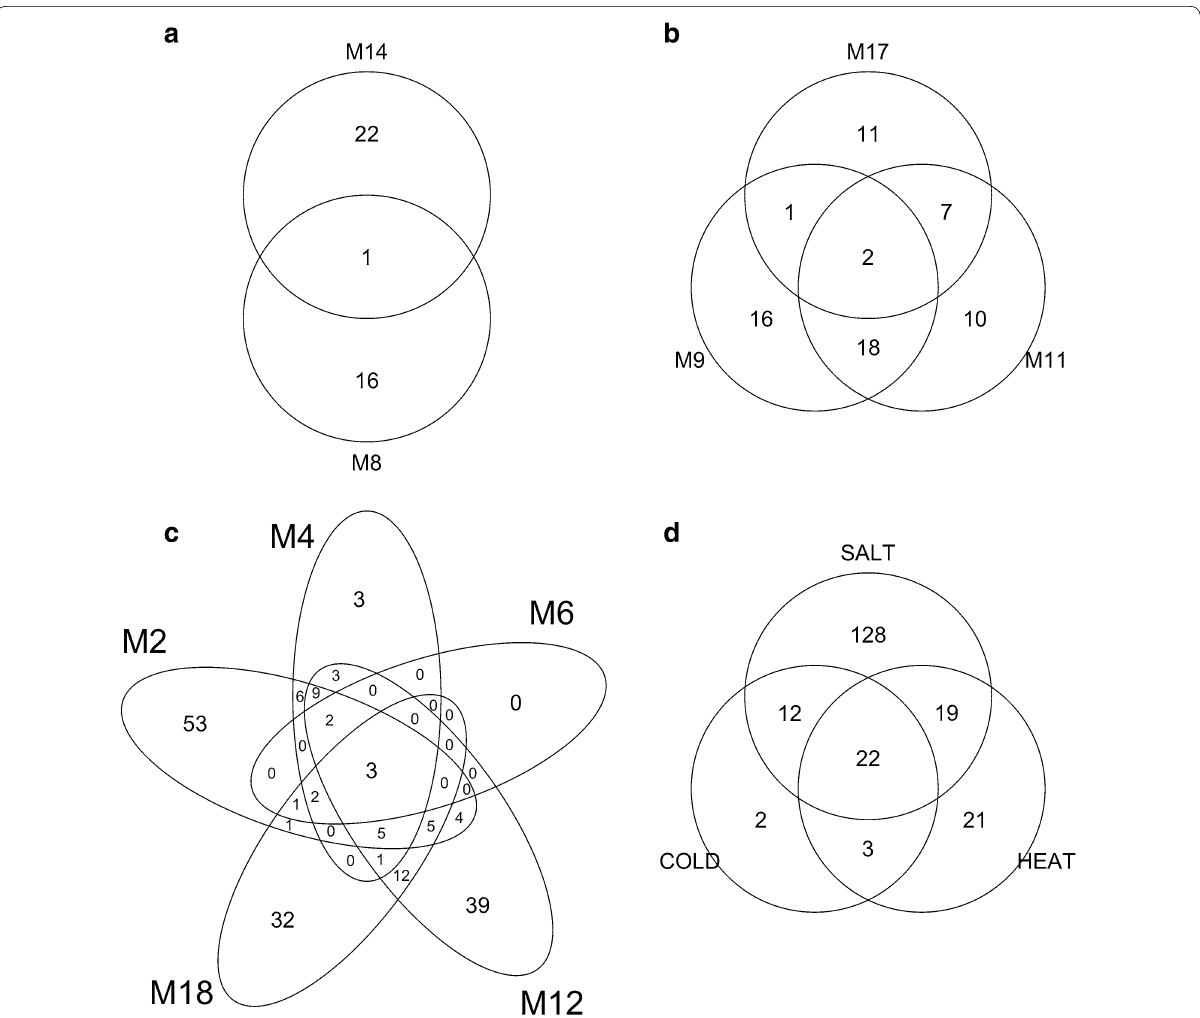
Fig. 4 Venn diagrams of enriched gene ontology items. Those venn diagrams were produced for a cold‑specific, b heat‑specific, c salt‑specific, and d all stress‑specific gene modules. The numbers in the venn diagrams were the numbers of enriched GO items in the stress‑specific gene modules. For example, in a , there were 22, 16, and 1, GO items enriched in M14 only, M8 only, and in both M8 and